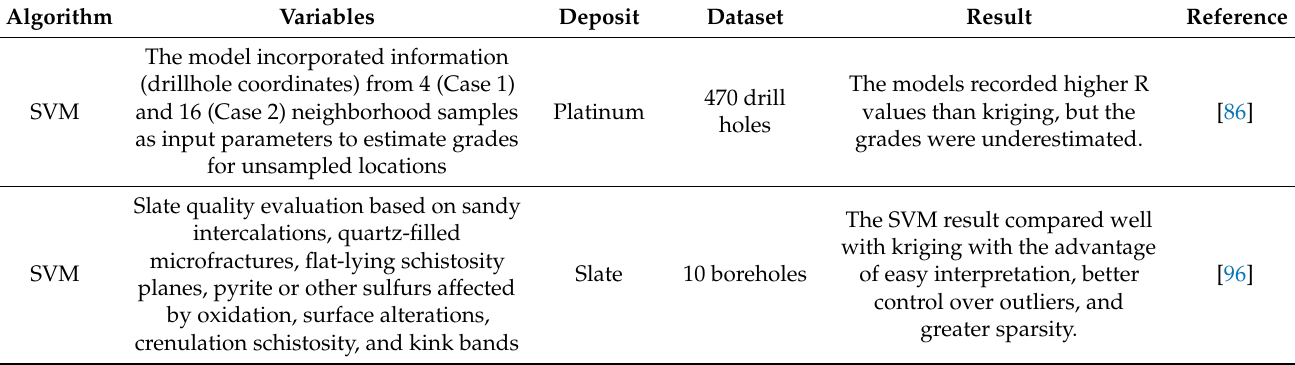
Table 4. Sample case studies of SVM-based mineral resource